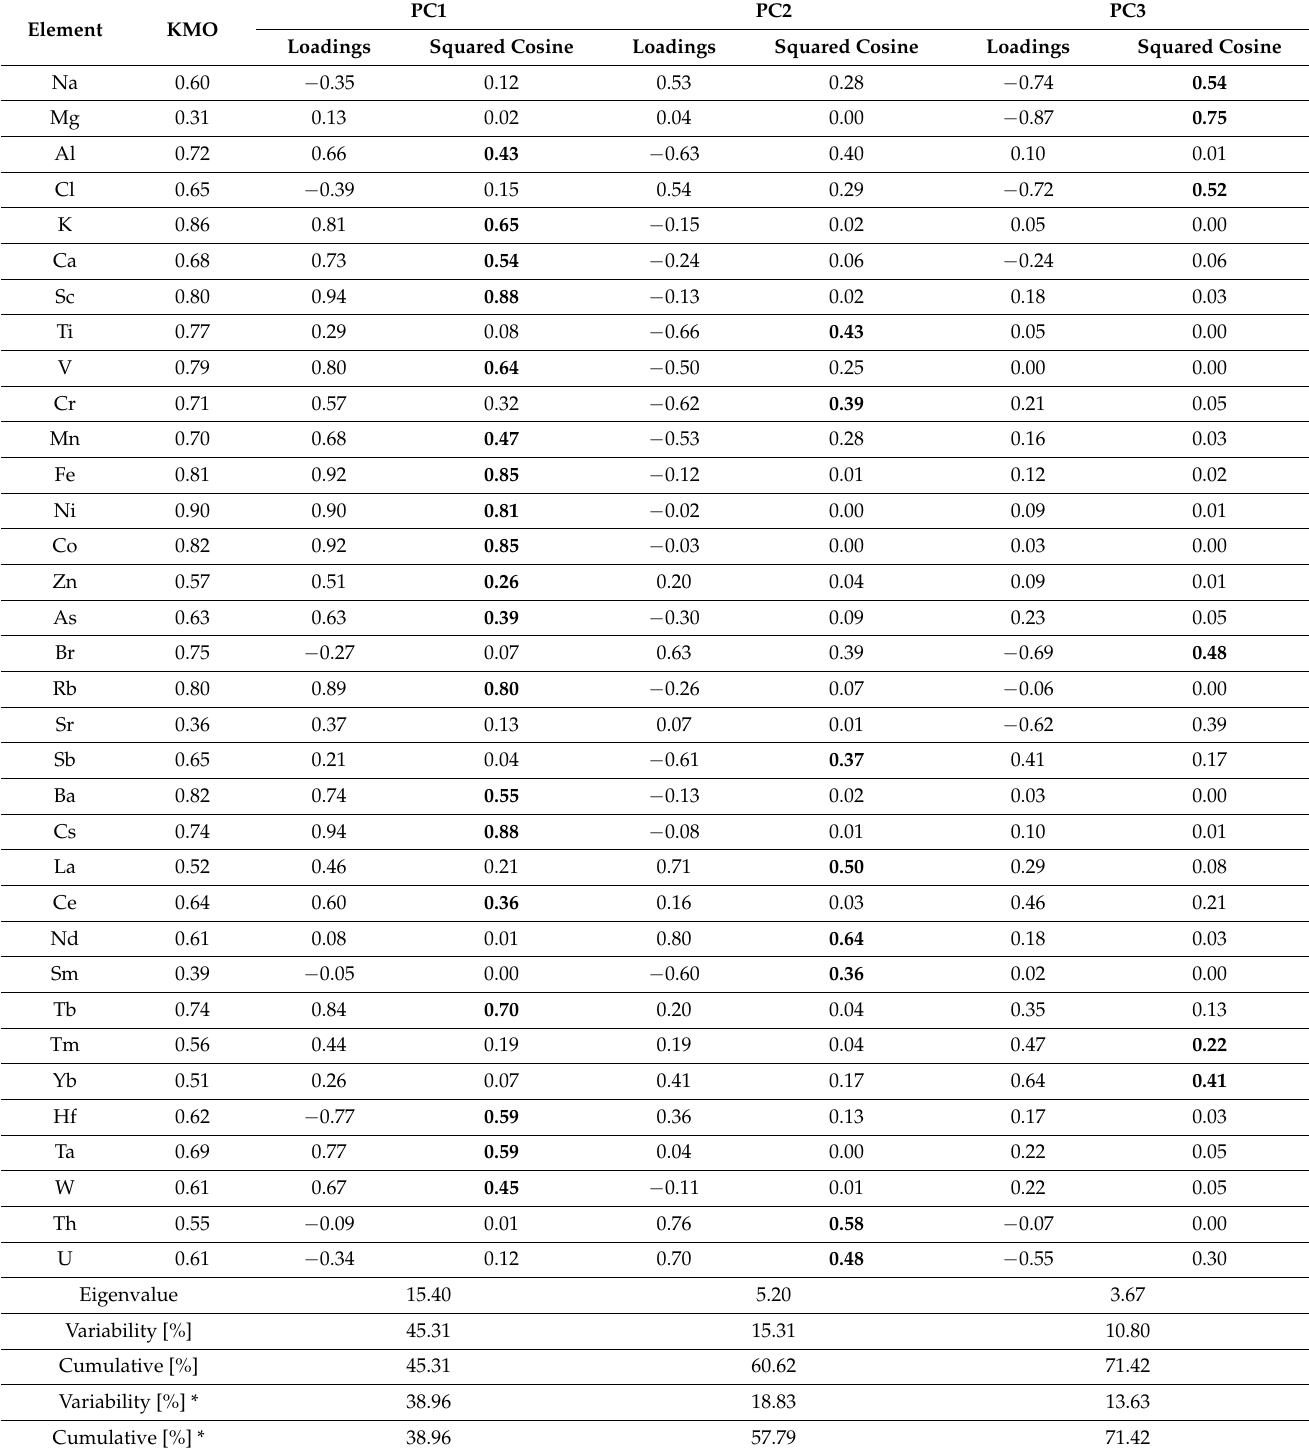
Table 8. Principal component analysis data for the elements quantified in sediment sample of Movila Miresii